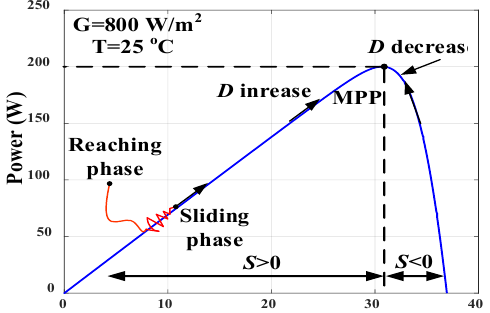
Figure 8. Principle of SMC strategy.